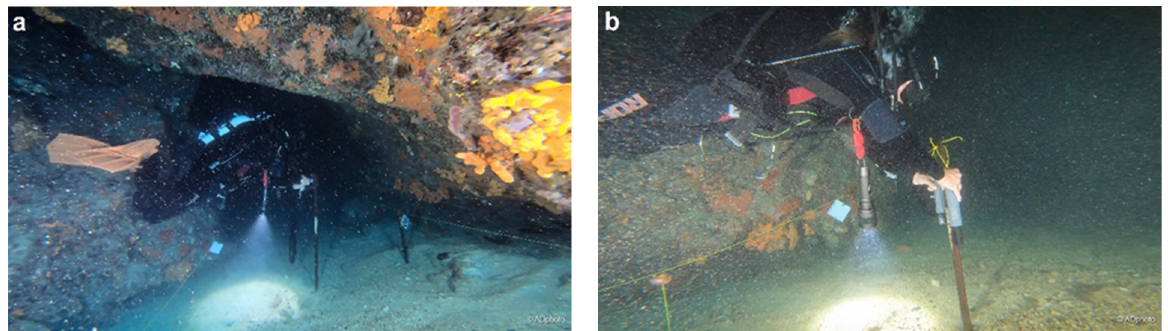
Figure 2. Evidence of outflow of water with sediment particles through the cave entrance during sampling procedures; ( a ) placement of numbered peg and multiparametric probes for morphological survey in Elle cave ( b ). Photos by Adelmo Sorci.